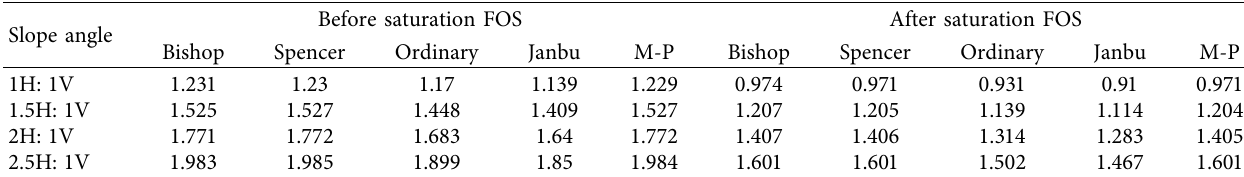
Table 12: FOS values for slope-5 for different slope angles before and after saturation.